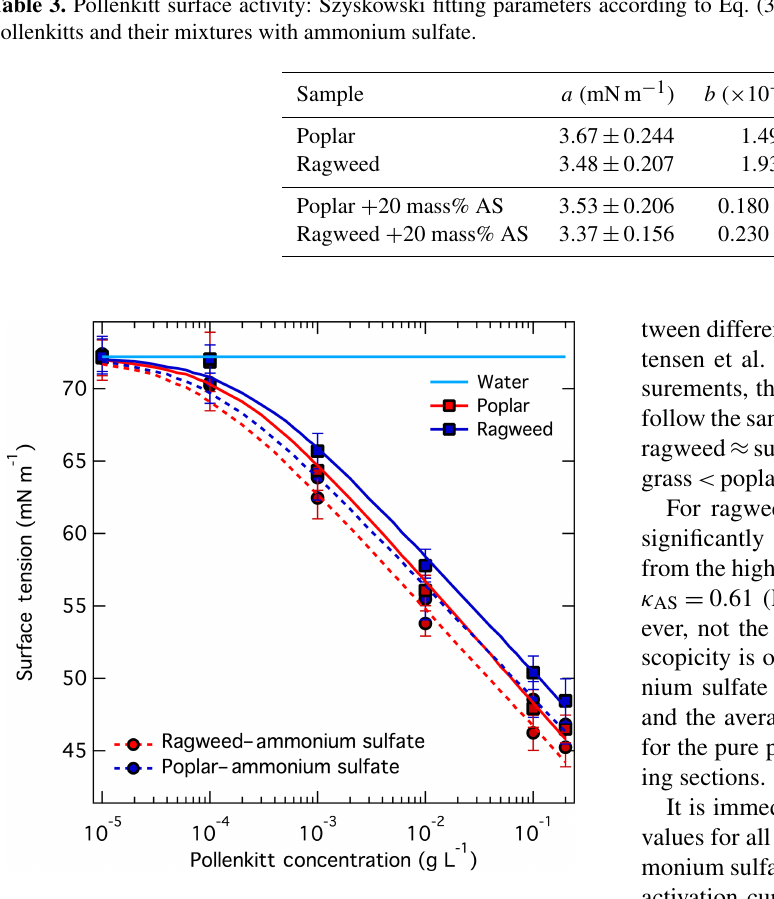
Figure 2. Measured surface tension of ragweed and poplar pol- lenkitts and their 20% by dry solute mass mixtures with ammonium sulfate, together with curves predicted by the parameterization of Eq. (3) and fitting parameter values given in Table